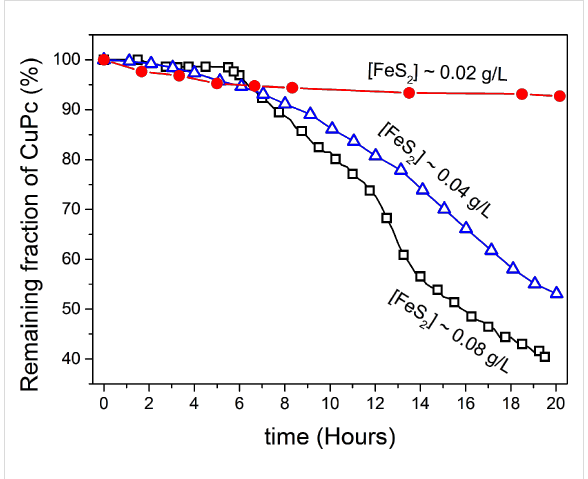
Figure 5: Effect of pyrite nanoparticle loading on the rate of CuPc decoloration. ([CuPc] 0 = 0.1 mg/L, loadings values are marked in the